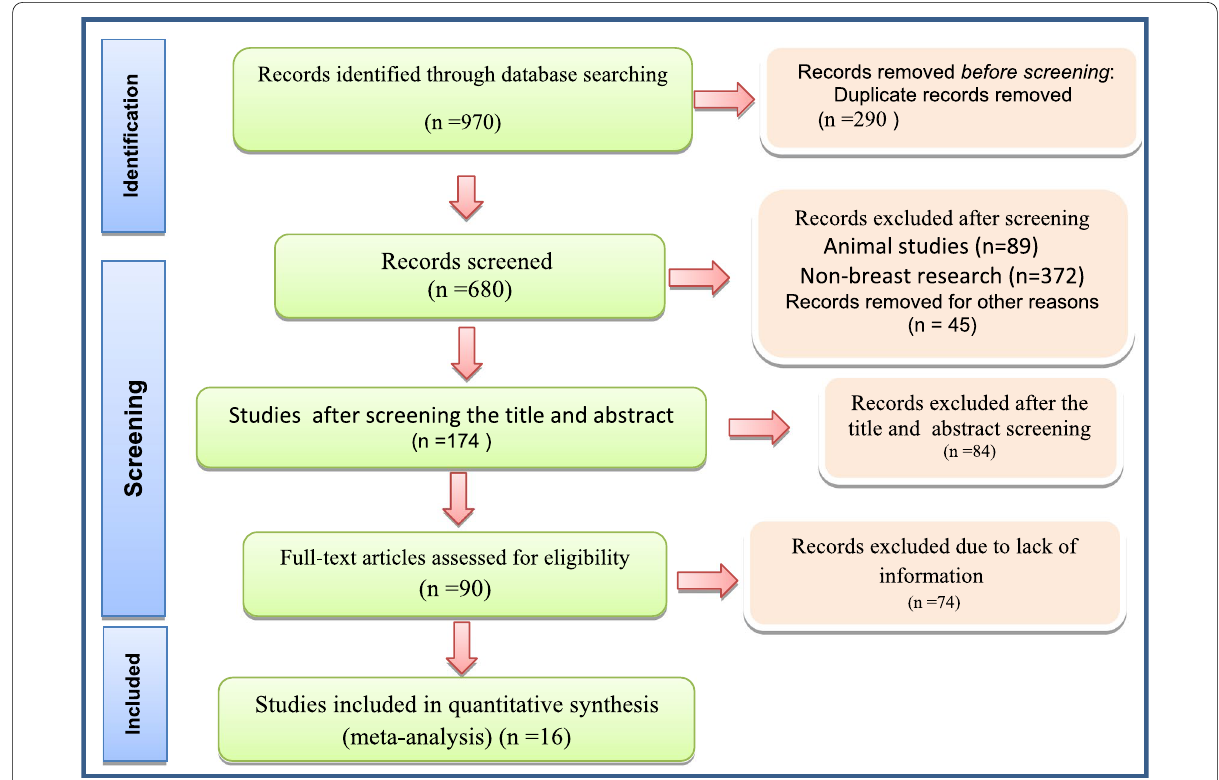
Fig. 1 PRISMA flow diagram for included studies in the current